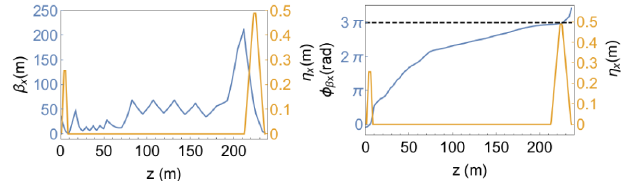
FIG. 7. Left: the beta function, β x , (blue) and dispersion in the bend plane, η x , (yellow). Right: the betatron phase advance, ϕ β x , (blue) and dispersion in the bend plane, η x (yellow) with the dashed line showing the phase advance at the second octupole. Here quantities are taken from ELEGANT simulations and are plotted from the entrance of BC1 ( z ¼ 0 ) to the exit of